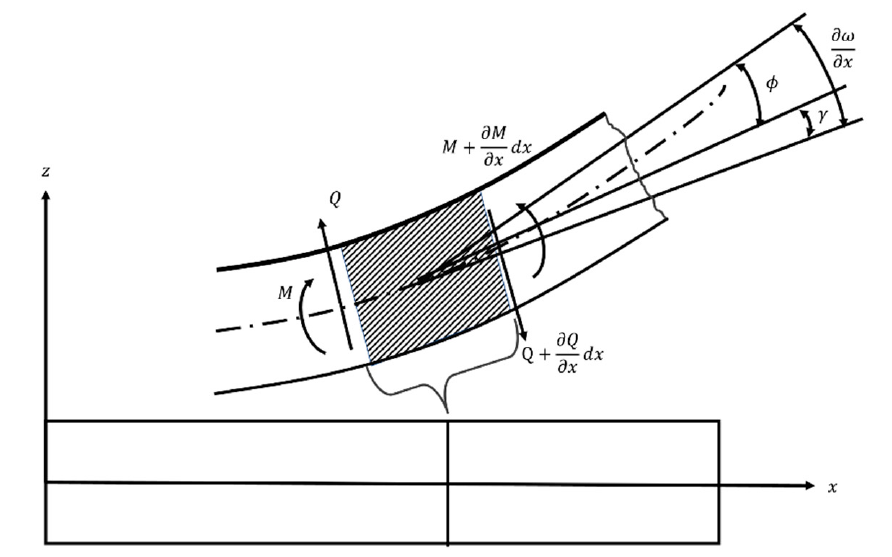
Figure 5. A Timoshenko beam and element of the beam.